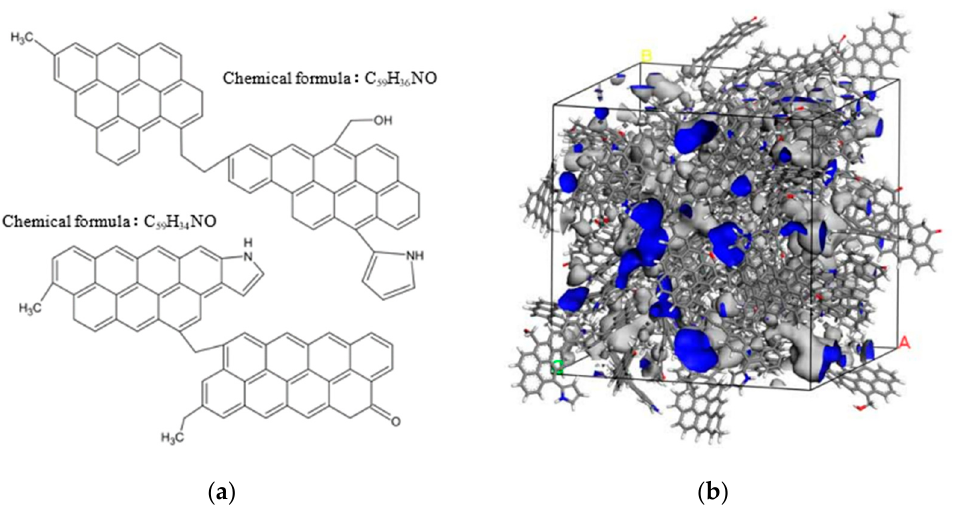
Figure 2. ( a ) Molecular structure of Jincheng Anthracite; ( b ) 3D structure model of Jincheng An ‐ thracite (the blue part indicates the pores).